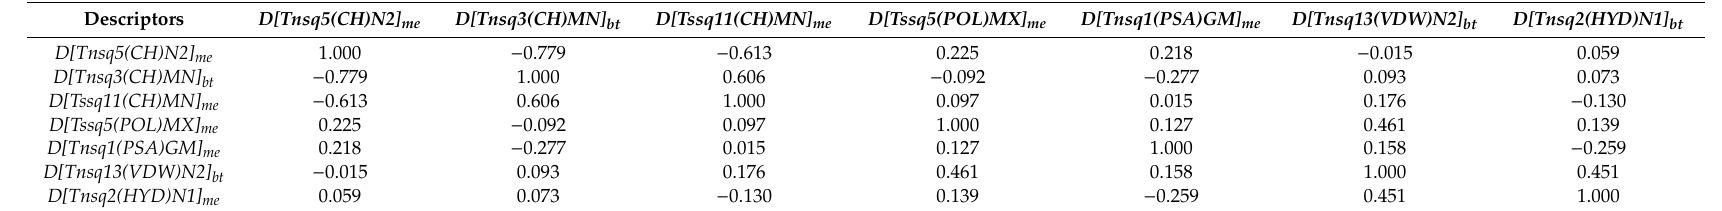
Table 2. Degree of collinearity among the variables of the mt-QSAR-LDA